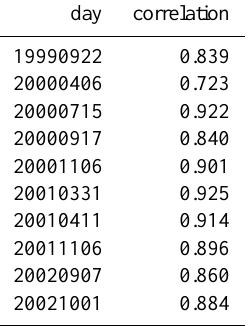
Fig. 7. Snapshots of the calculated electric (cid:2)eld on April 11, 2001, using the local 1D method and the earth model of Table 2. The main parts of the Finnish natural gas pipeline are sketched in the (cid:2)rst plot with blue lines and the measuring site at M¤ants¤al¤a is marked as a black dot. The Finnish 400 kV and 220 kV power lines are shown in the second plot with blue lines. The Rauma and Yllikk¤al¤a 400 kV transformers are the black dots in the west and east, respectively. 28